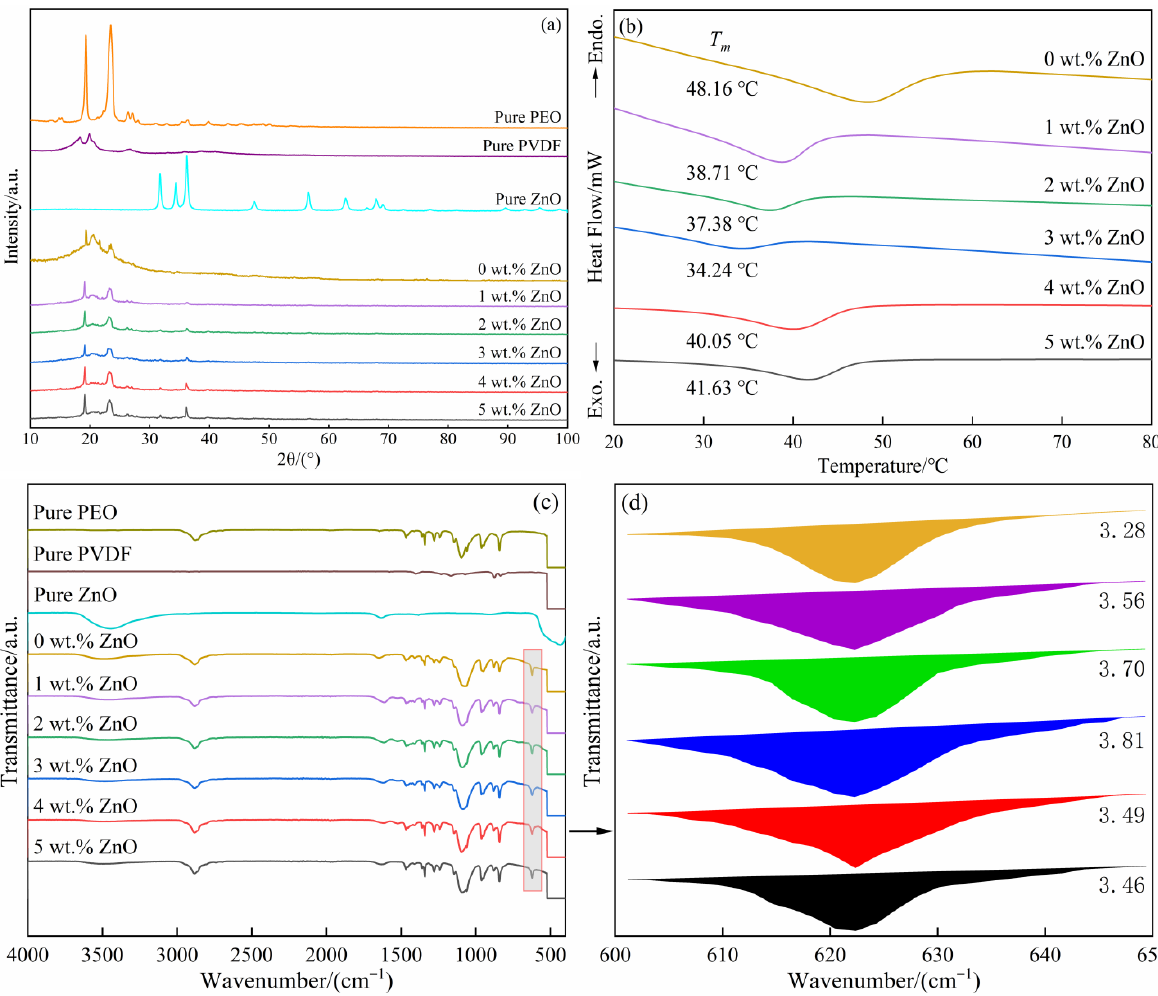
Figure 1. XRD patterns ( a ) of the SPEs (0 wt.% ZnO [26], 1–5 wt.% ZnO), and three pure substances (PEO, PVDF, and ZnO) [26]; DSC curves ( b ) of the SPEs (0 wt.% [26], 1–5 wt.%); FTIR spectra ( c ) of the SPEs (0 wt.% [26], 1–5 wt.%) and three pure substances (PEO, PVDF, and ZnO) [26]; and the local magnification ( d ) of the SPEs (0 wt.% ZnO [26], 1–5 wt.% ZnO).